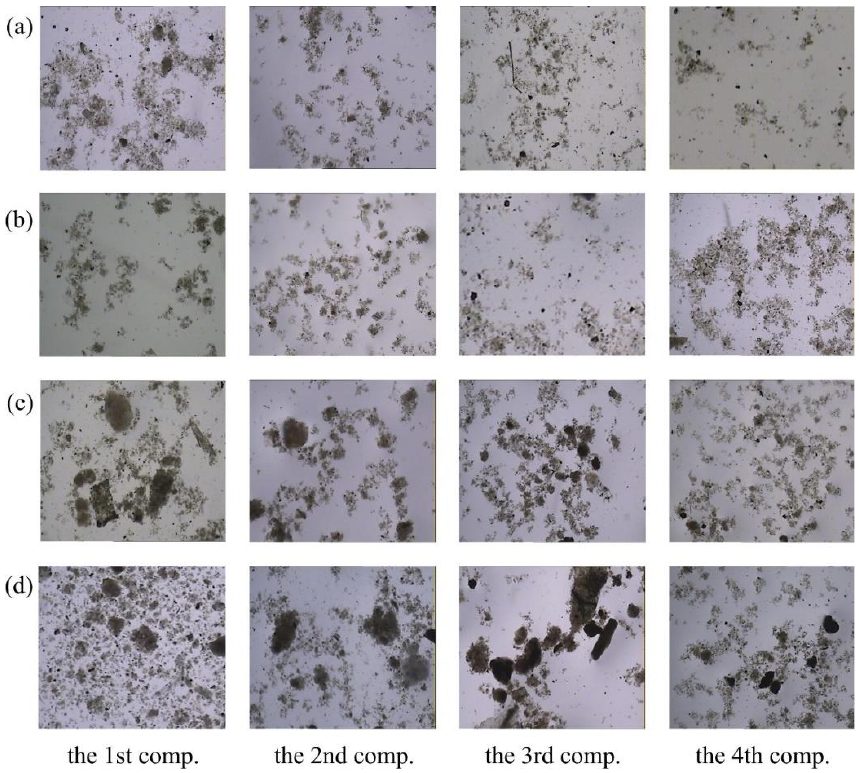
Figure 2. Captured images of the sludge in four compartments on ( a ) the 12th day; ( b ) the 25th day; ( c ) the 35th day; ( d ) the 45th day during start-up (10×).